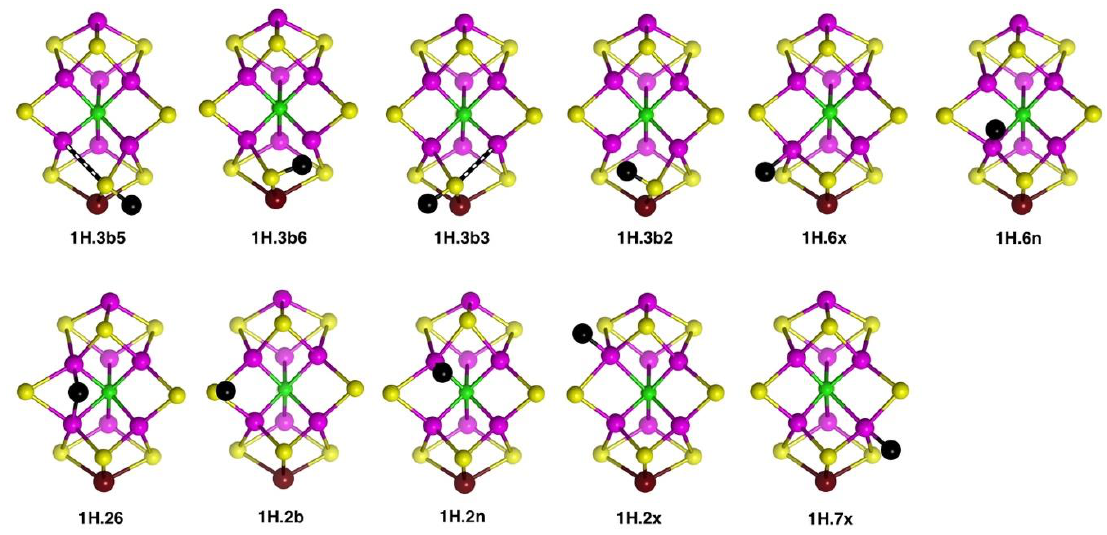
Figure 3. The optimised structures for FeMo-co bearing one H atom (black). These pictures are simplified by hiding the ligands at Fe1 and Mo. Fe–S distances < 2.5 Å are drawn as bonds, and Fe–S distances in the range of 2.5 to 3 Å are marked with a black/white striped connector.